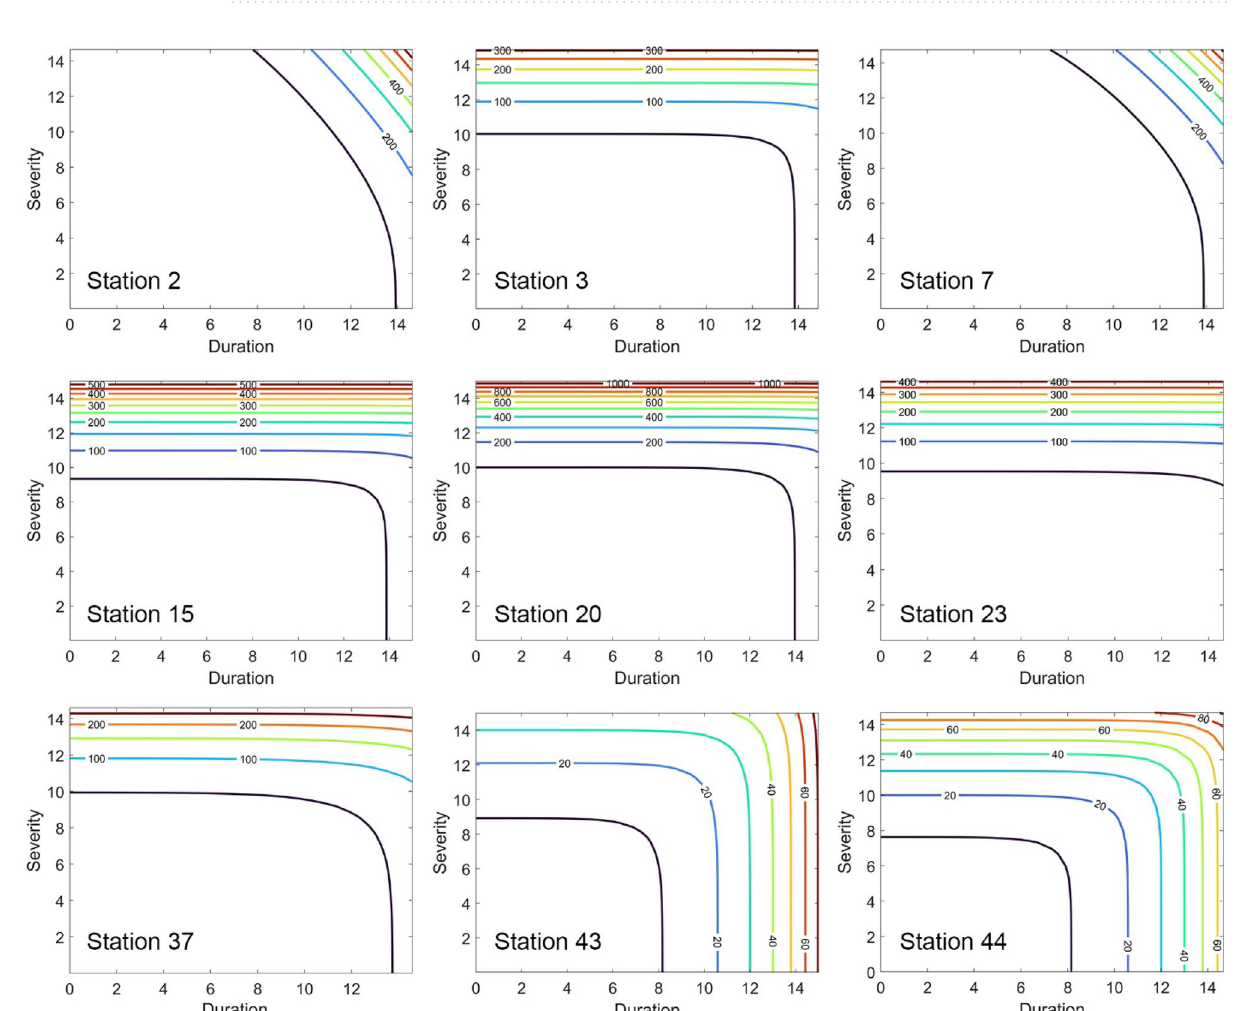
Table 2. Groundwater drought: statistical parameters for the fitted marginal distributions and copulas in 158 observation wells.